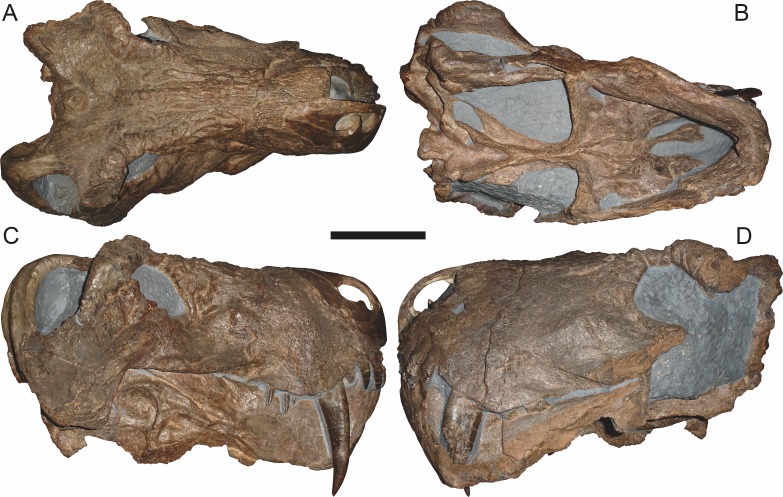
Referred specimen (GPIT K16) of Dinogorgon rubidgei
Broom, 1936 in (A) dorsal, (B) ventral, (C) right lateral, and (D) left lateral views.Holotype of Dinogorgon quinquemolaris
Huene, 1950. Scale bar equals 10 cm.